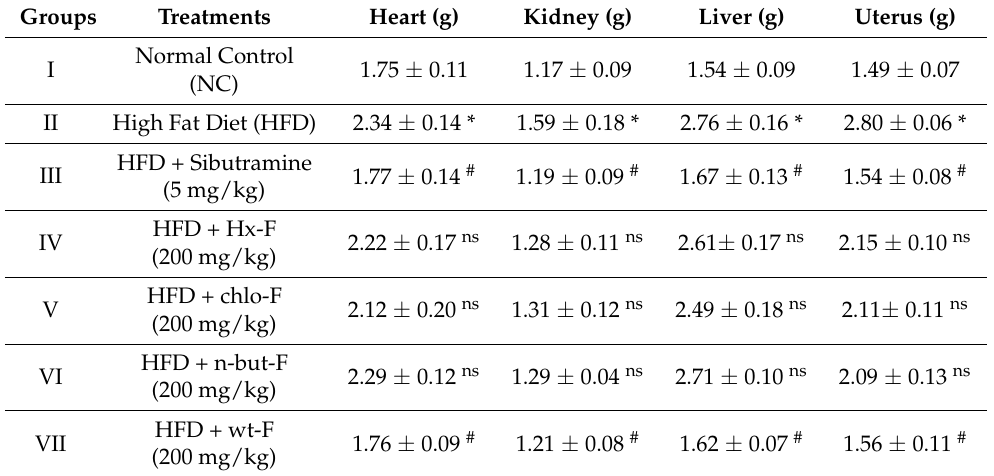
Table 6. Effects of Wt-F of B. diffusa extract on the visceral fat pad in SD rats after 60 days of treatments.